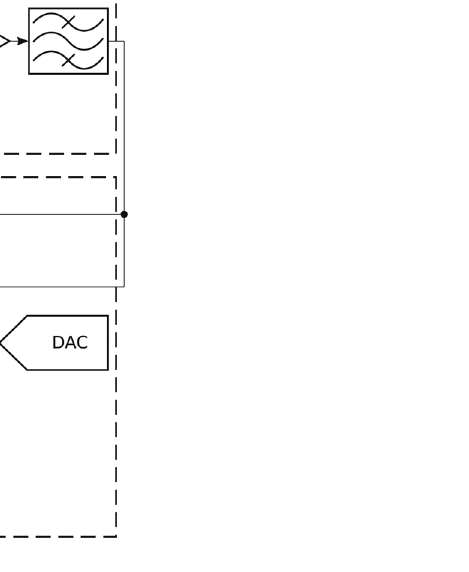
Figure 5. Simplified block scheme of